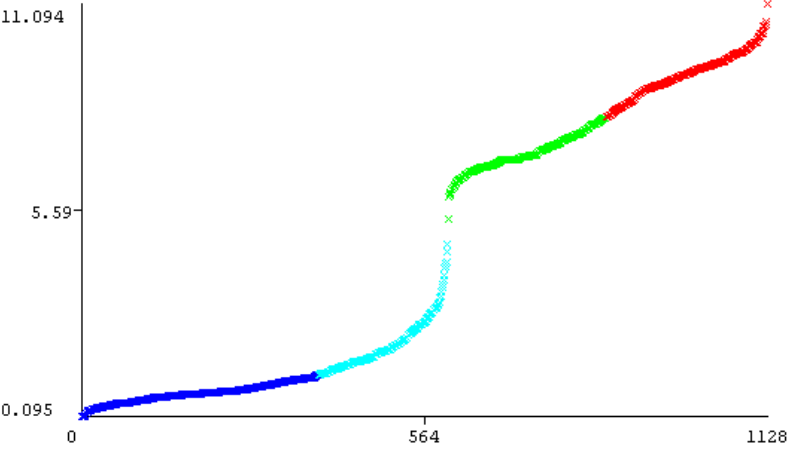
Figure 1. ln(x+1) clustering by EM, where x is Ni concentration data expressed in ppm. Four clusters can be observed: cluster 0 (blue), cluster 3 (cyan), cluster 2 (green) and cluster 1 (red). Weka gives the number of the cluster; it has no biological meaning. Y-axis shows the value of ln(x+1), whereas X-axis shows the number of the instance (the order of Ni datum in the original data file, where values were ordered from lowest to